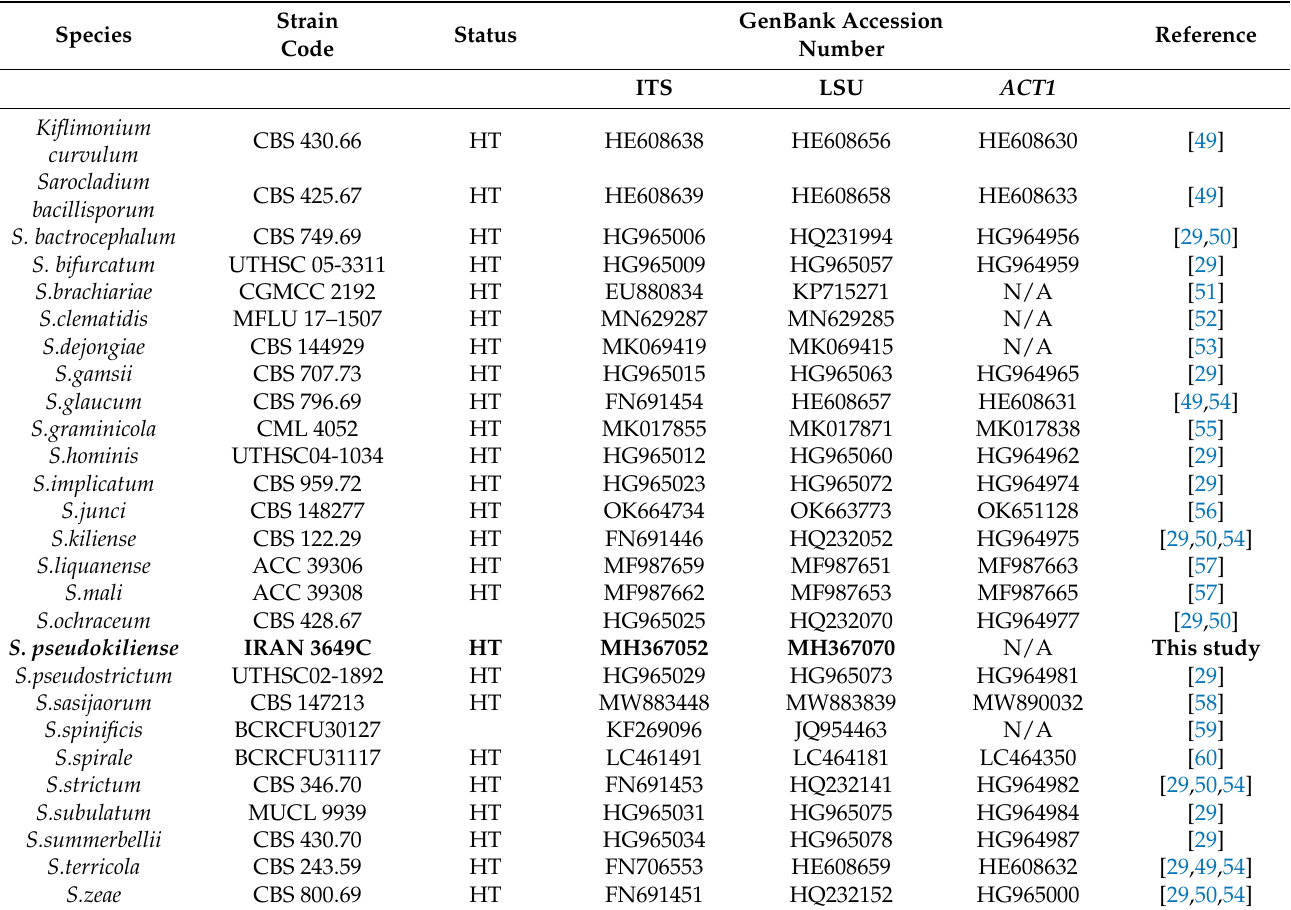
Table 2. Strain codes and GenBank accession numbers of sequences used in the phylogenetic analyses of Sarocladium , spp. Type specimens are labeled with HT (holotype). Isolates/sequences in bold were isolated/sequenced in the present study. N/A: not